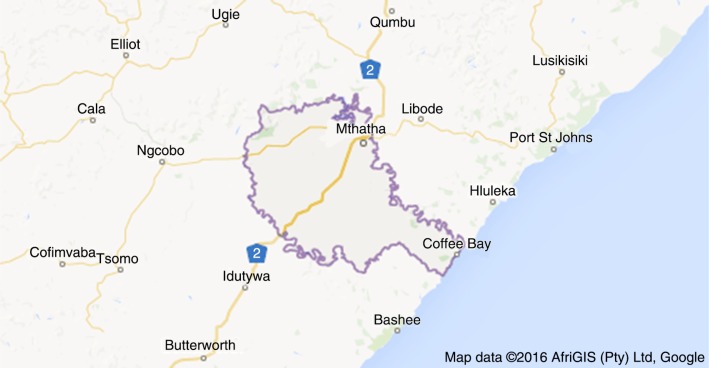
Map showing the geographical location of King Sabata District Municipality, Eastern Cape, South Africa.